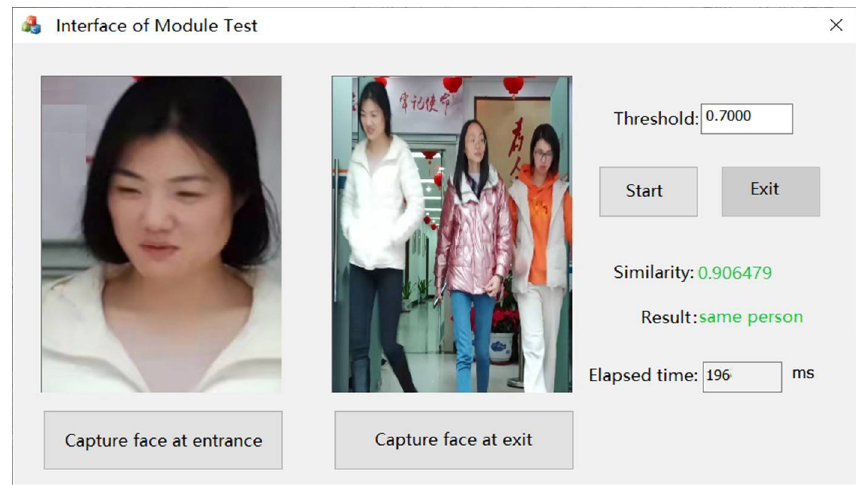
13 of 16 Figure 9. Personal tracking system with face verification devices. ( a ) Face verification device. ( b ) Network architecture of the prototype system. In order to test the proposed model in a real scenario at factory gates, we have de- signed a test interface for gate face verification devices, which is used to capture face im- ages from the factory entrance and the exit. The interface is shown in Figure 10. When a person enters the factory, the face can be captured as shown in the left box of the interface. It should be noted that the device/system has not stored the picture/image of the person. The system has only stored the extracted features, which consist of a vector with 512 val- ues represented for example P in in Section 1. The values cannot be reversed to image/pic- ture, so the system does not store private personal images and does not result in any eth- ical issues. As the features are captured in the entrance and updated every day, the system is very robust against some changes to a person’s face. In order to test the proposed model against the lateral face and multi-faces in one image, the camera was installed far away